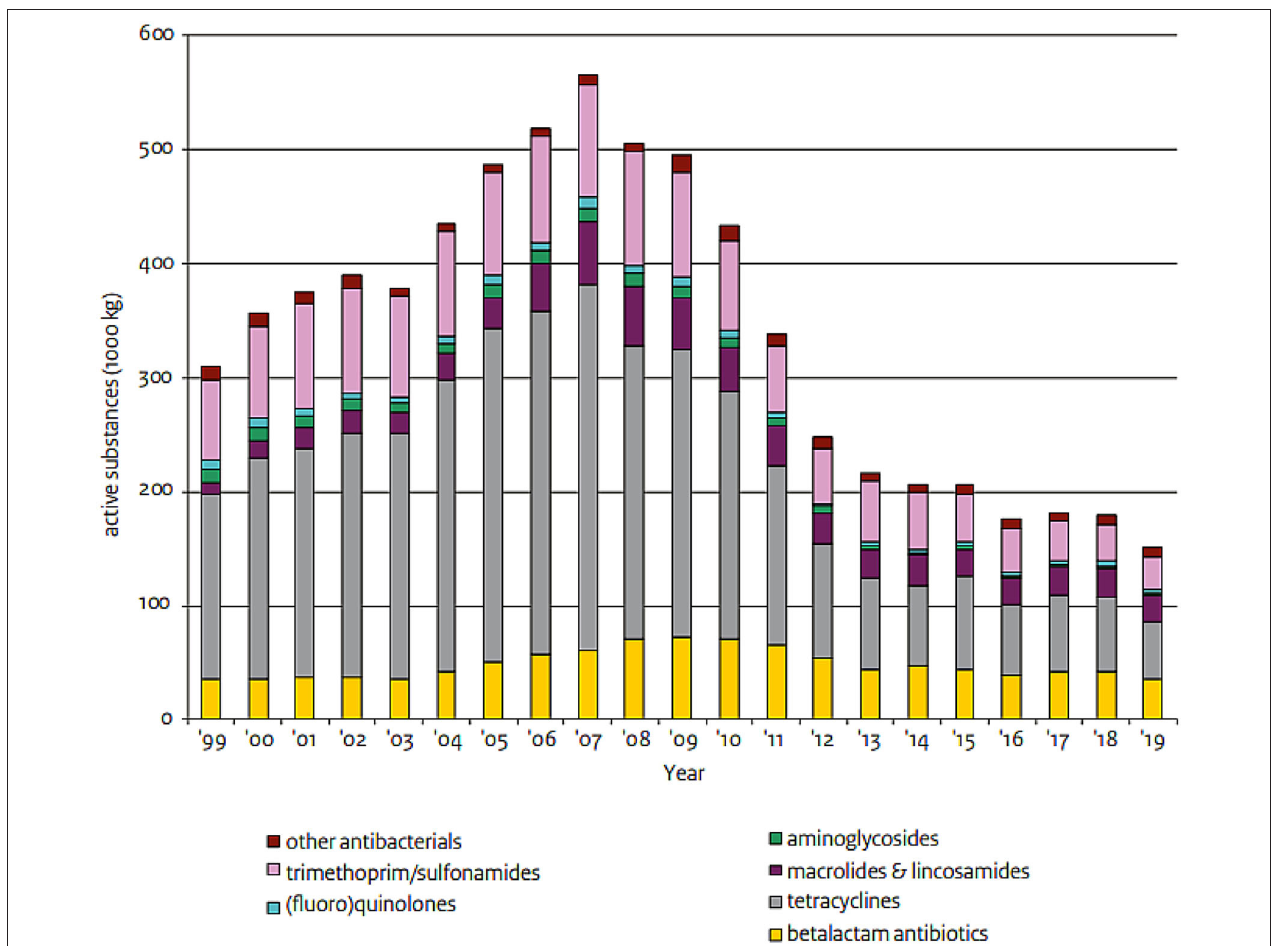
FIGURE 1 | Antimicrobial veterinary medicinal product (AVMP) sales 1999–2019 in kg (thousands). Trends in antibiotic sales from 1999 to 2019 in The Netherlands. Reproduced from NethMap (7).